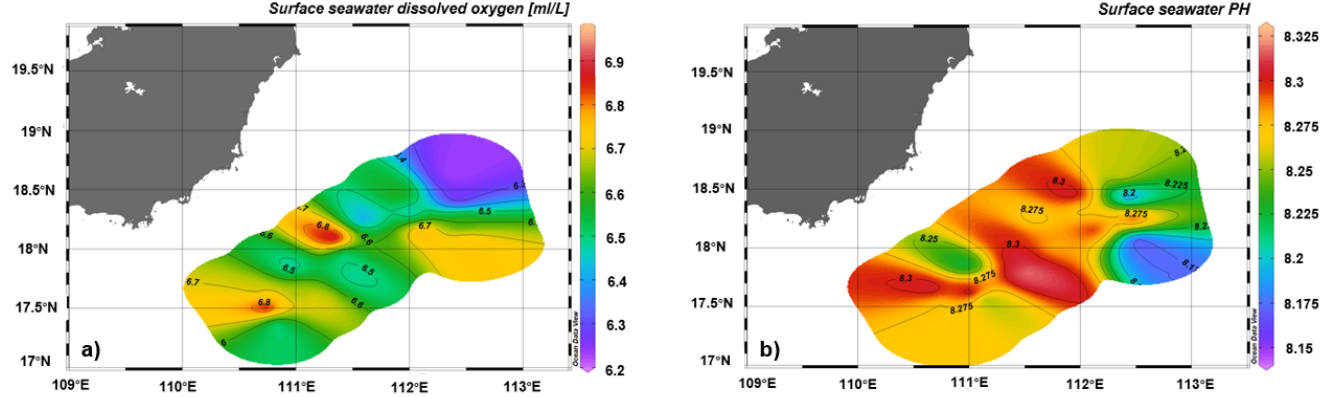
Figure 11. ( a ) Distribution map of surface seawater dissolved oxygen and ( b ) surface seawater pH in the Qiongdongnan area in June 2019.